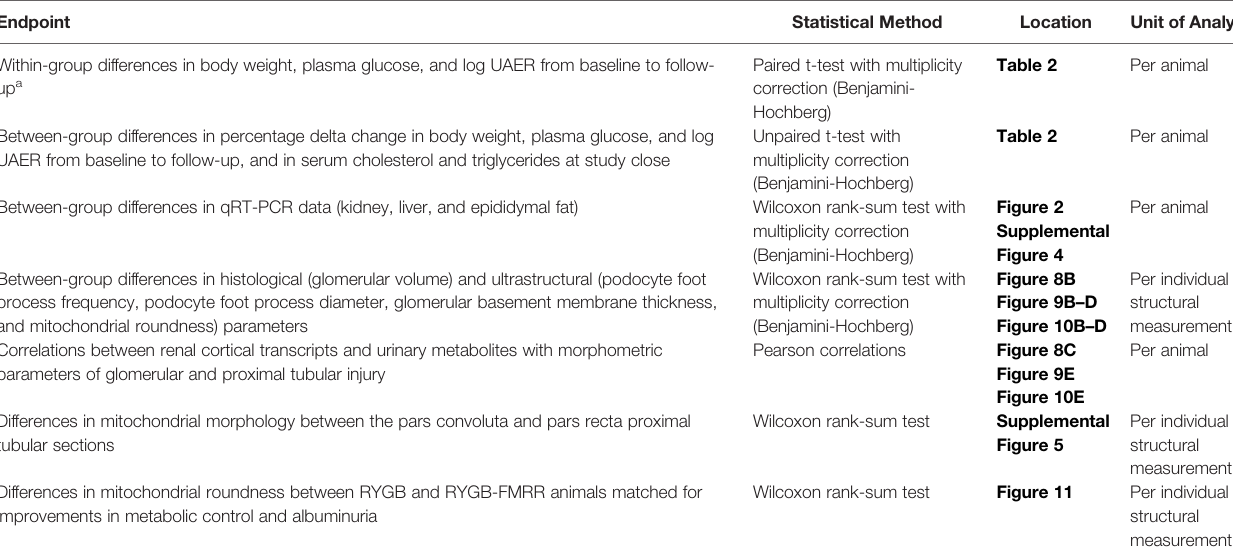
TABLE 1 | Study endpoints and statistical tests by which they were analyzed a .